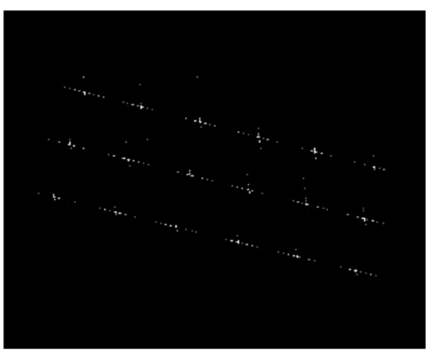
Figure 5. Image after geometric